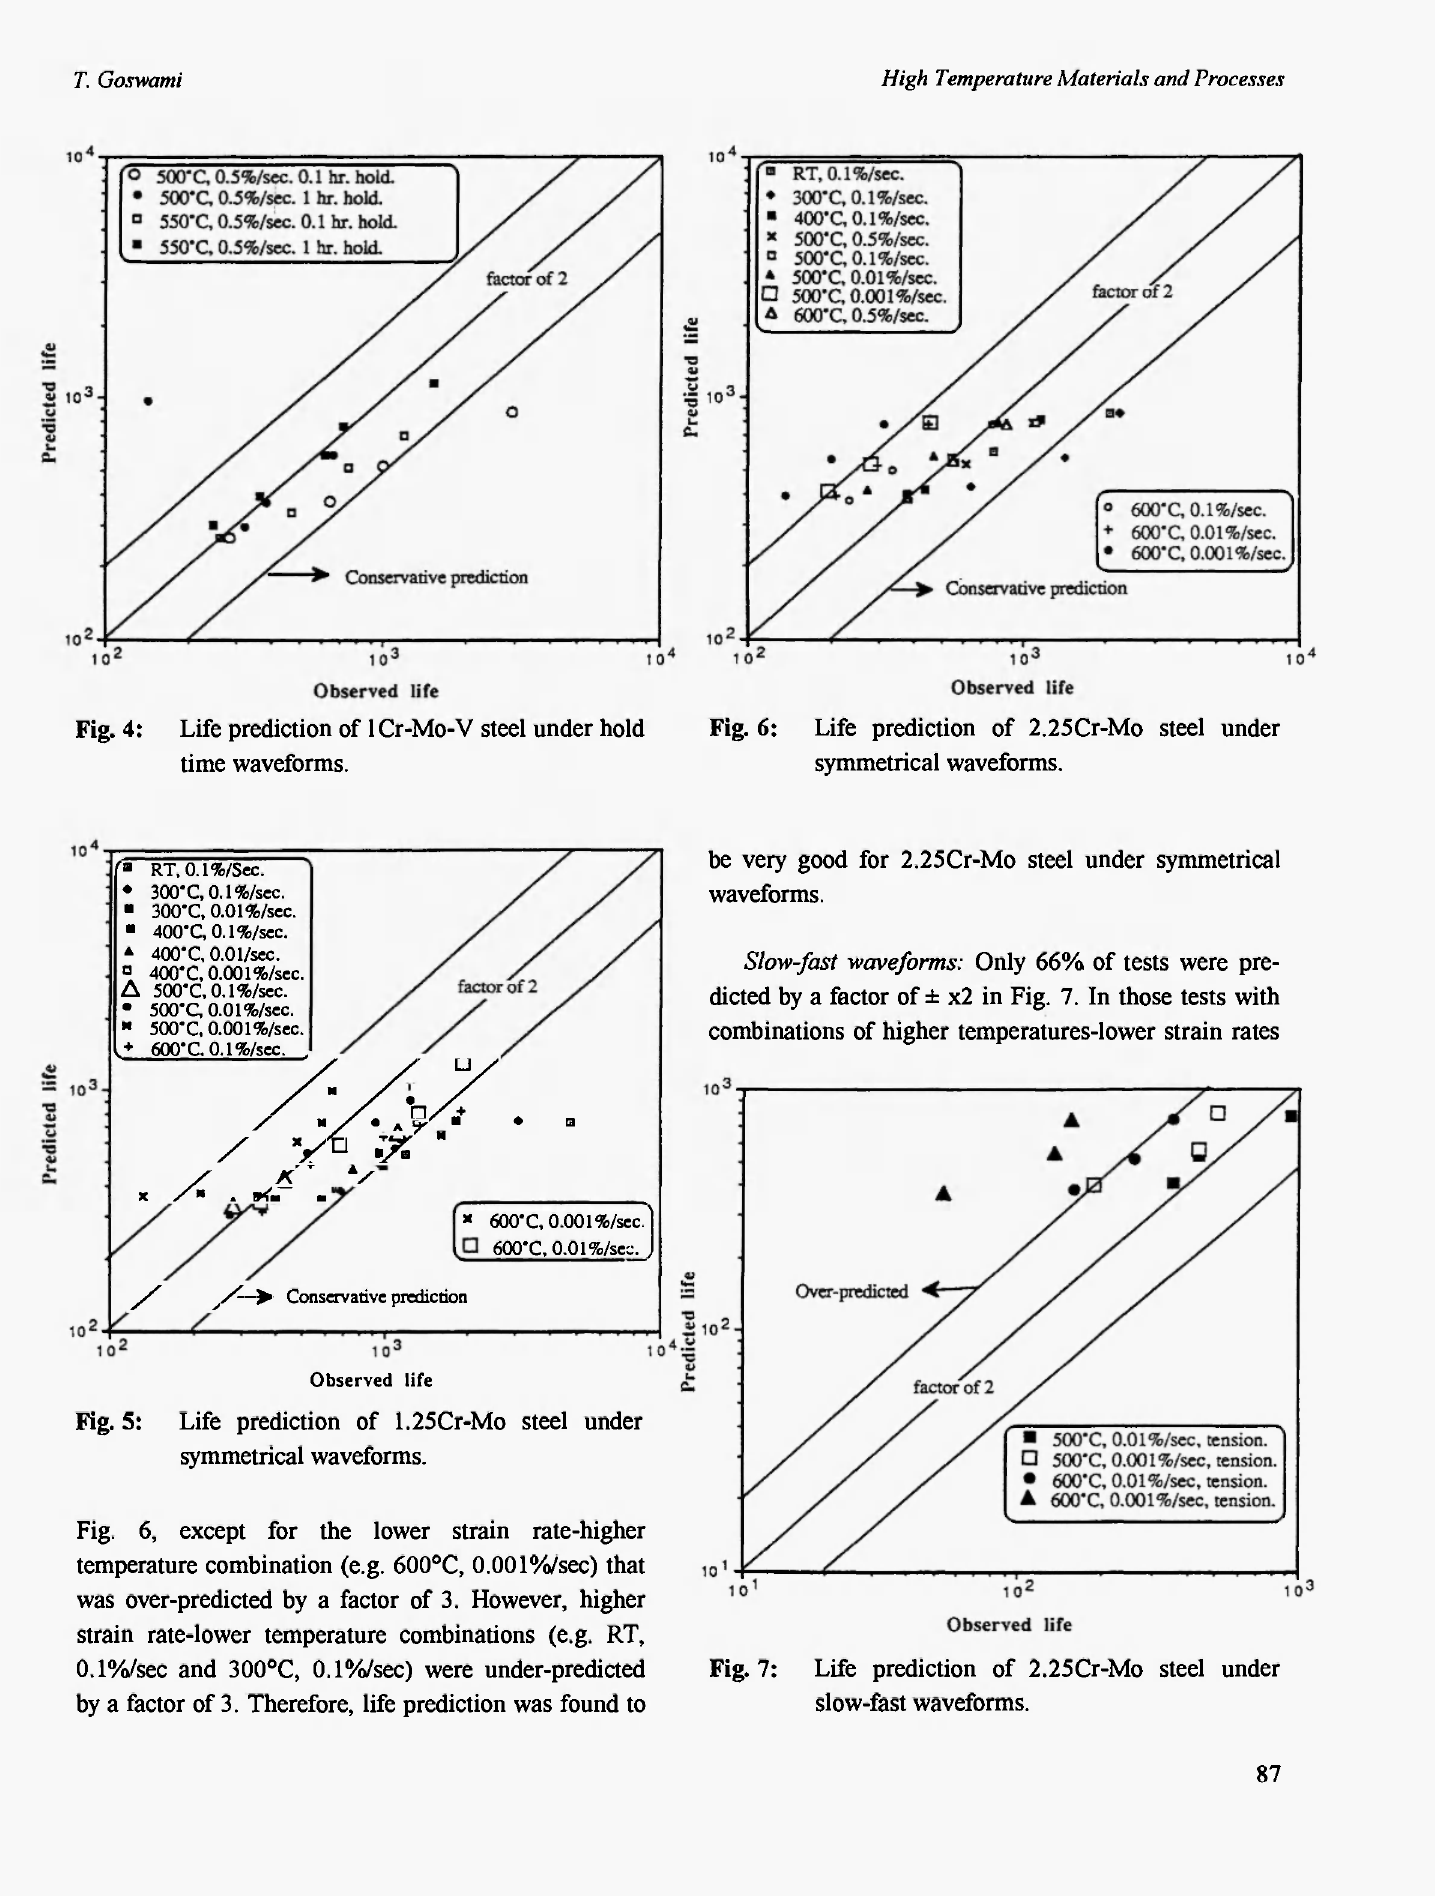
Fig. 5: Life prediction of 1.25Cr-Mo steel under symmetrical waveforms. Fig. 6, except for the lower strain rate-higher temperature combination (e.g. 600°C, 0.001%/sec) that was over-predicted by a factor of 3. However, higher strain rate-lower temperature combinations (e.g. RT, 0.1 %/sec and 300°C, 0.1%/sec) were under-predicted by a factor of 3. Therefore, life prediction was found to